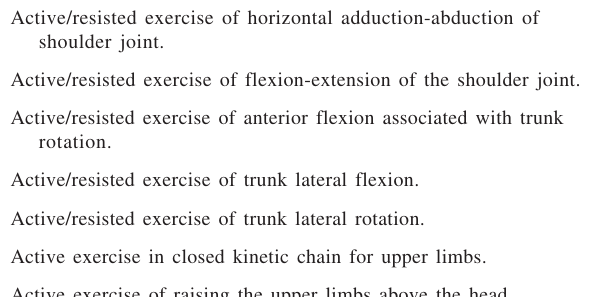
Table 1 - Program of respiratory exercise applied to water and land